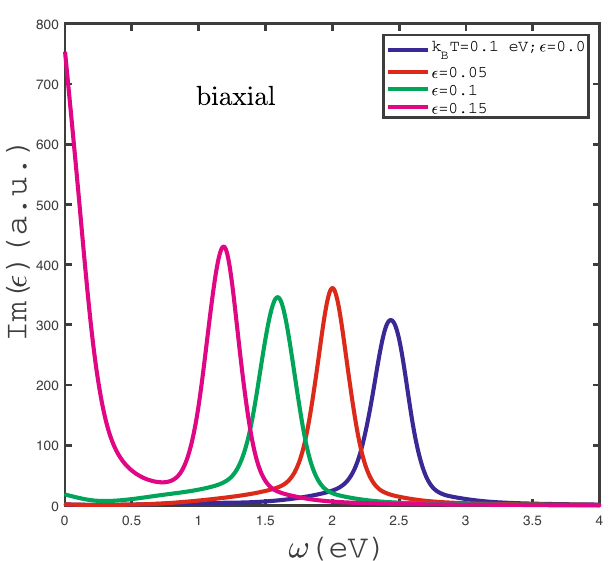
Figure 8. Optical absorption, Im (ǫ) , of undoped MoS 2 layer as a function of photon frequency in the presence of positive biaxial strain for different strain parameter , namely ε x of magnetic field at fixed temperature k B T